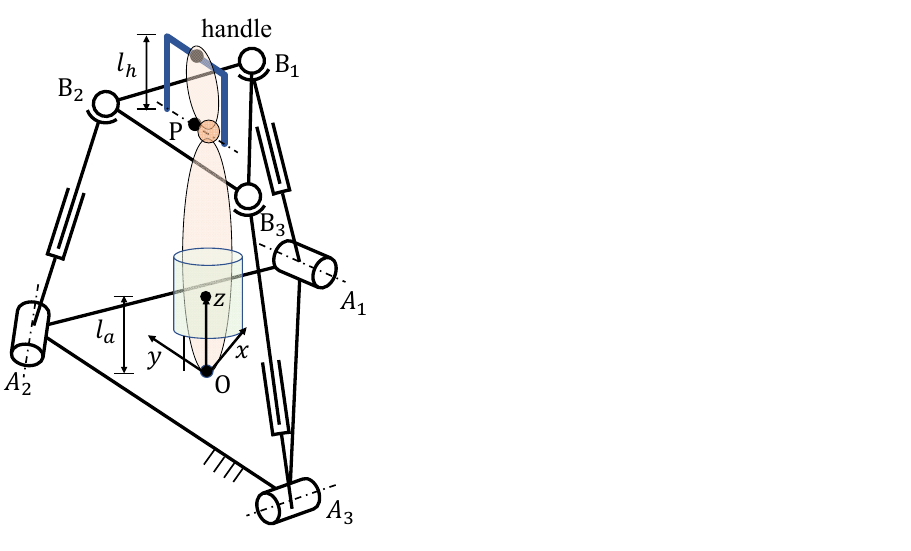
Figure 3. The sketch of a wrist rehabilitation robot and human limb [13]. Reprinted with permission from ref. [13]. 2021, Jc-IFToMM.